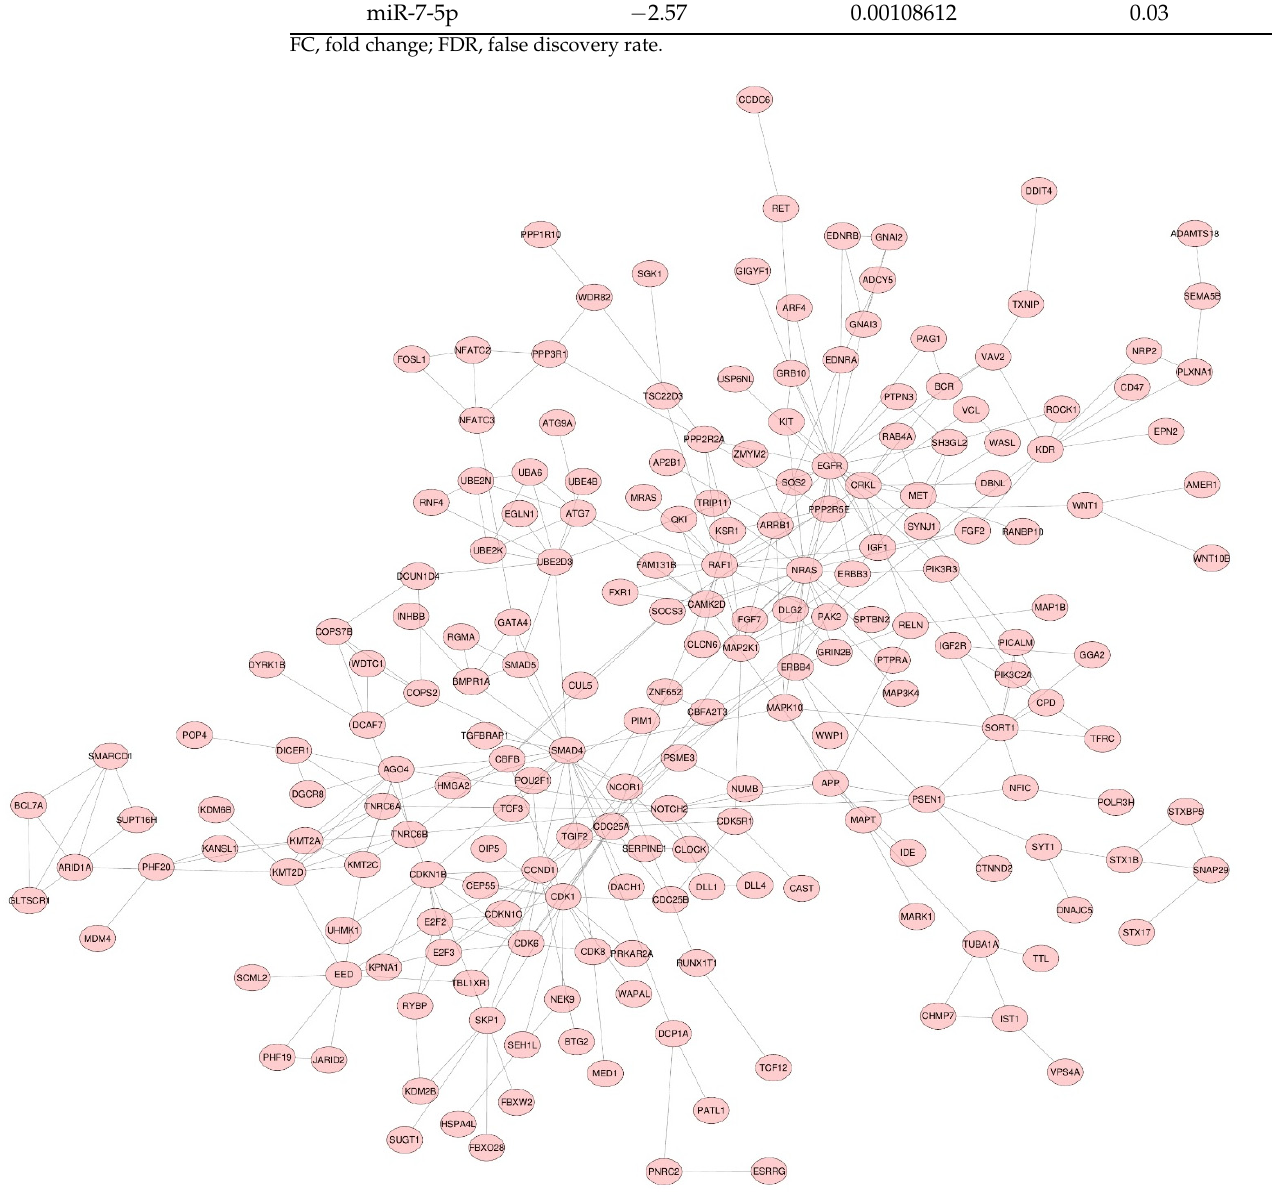
Figure 1. Target genes of DEMs rendered using STRING database. Only connected nodes are present. Only interactions with high confidence interaction scores (>0.9) are shown. The PPI enrichment value was predicted to be 8.44 × 10 − 15 .